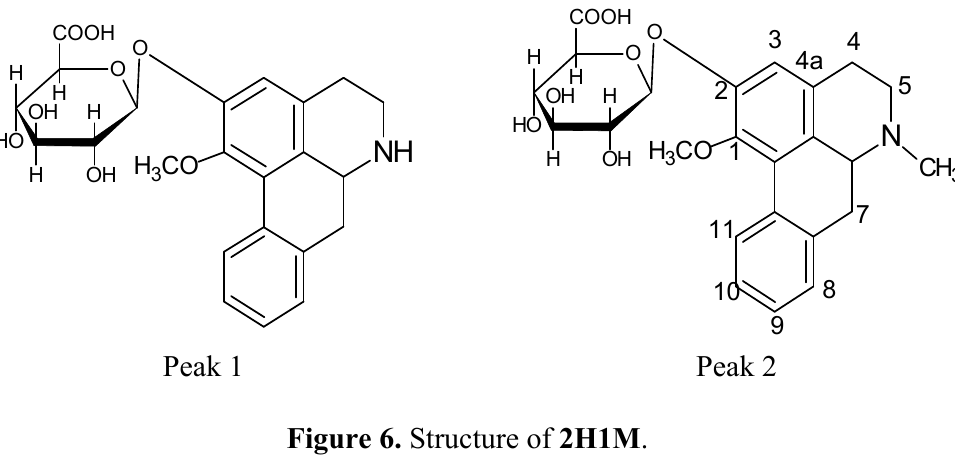
Figure 5. Structures of effective metabolites in JZN.